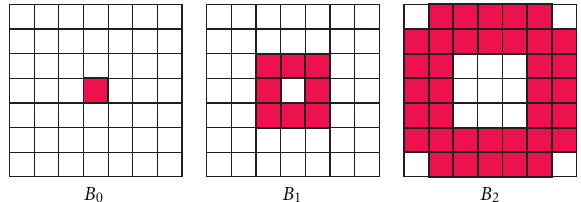
Figure 2: Cells which take part in the calculation of B 0 , B 1 , and B 2 surface